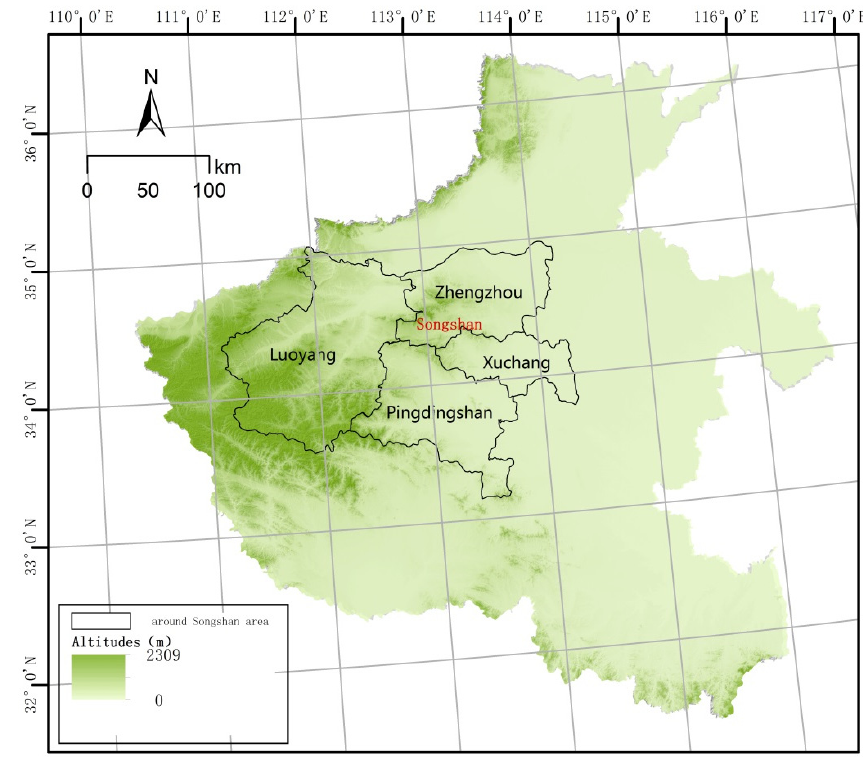
Figure 1. The location around the Songshan area.